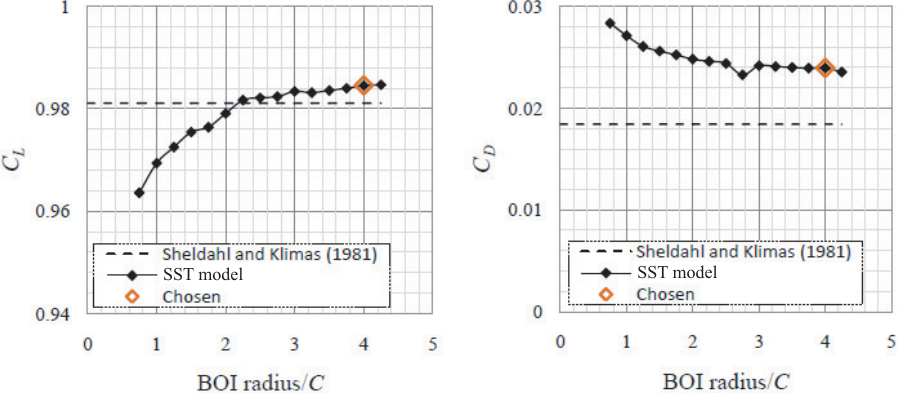
Figure 13. Variation in lift and drag as a function of body of influence radius with element sizing of 3 × 10 − 2 C .